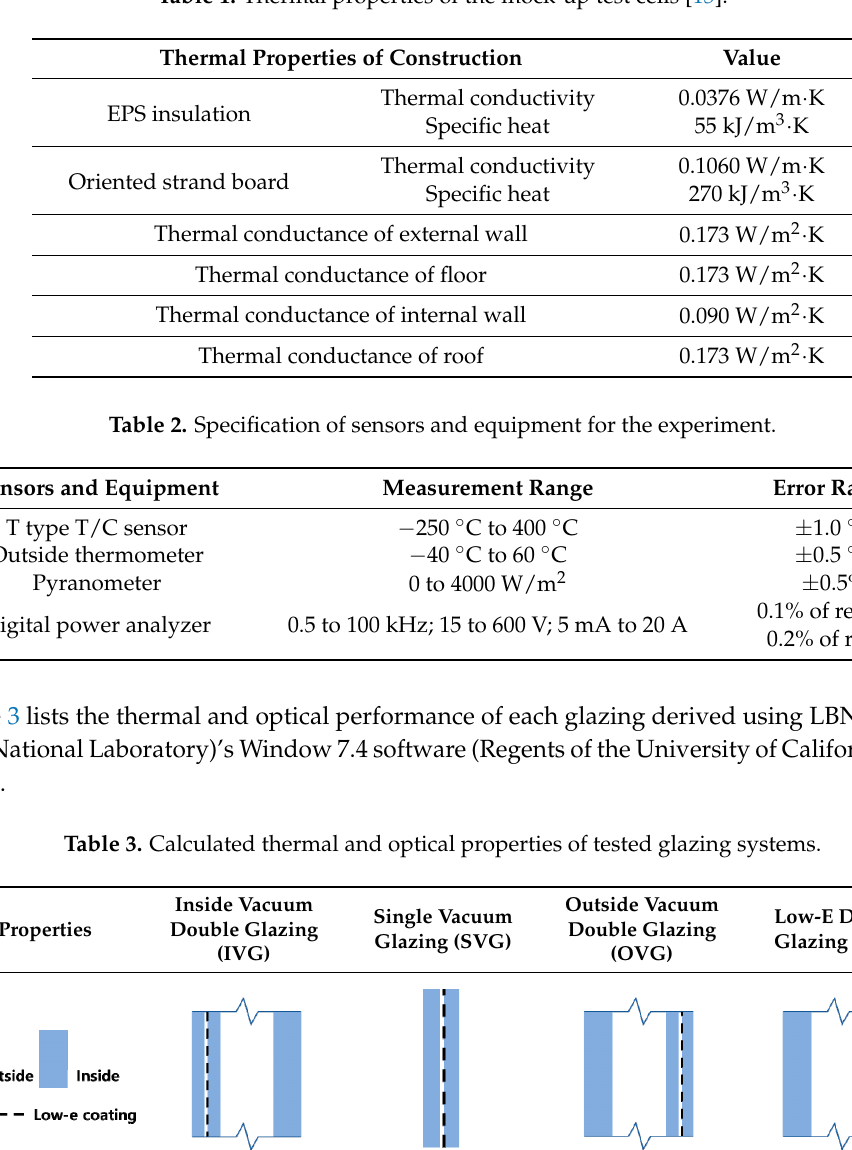
Table 1. Thermal properties of the mock-up test cells [15].